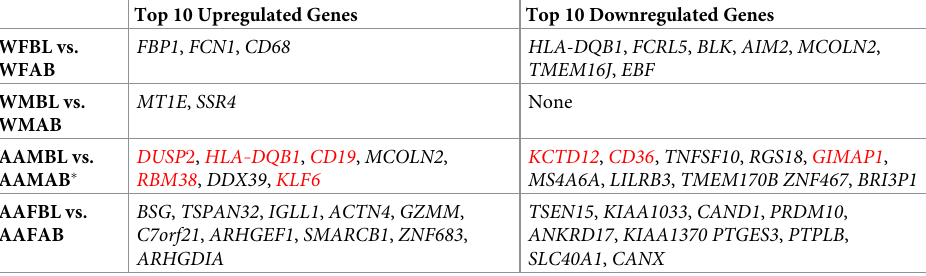
Table 1. Significantly-different genes by poverty